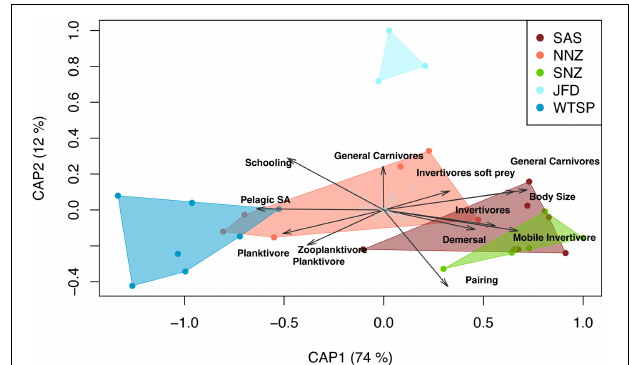
FIGURE 5 | Biplot of constrained Analysis of Principal Coordinates (CAP) explaining the proportion of the abundance of each trait category (for categorical traits) or abundance-weighted trophic level and body size (for continuous traits) of sampled